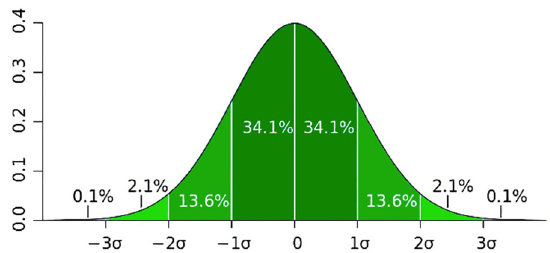
Figure 2. The interval that fulfils the Pauta (3 σ ) criterion.